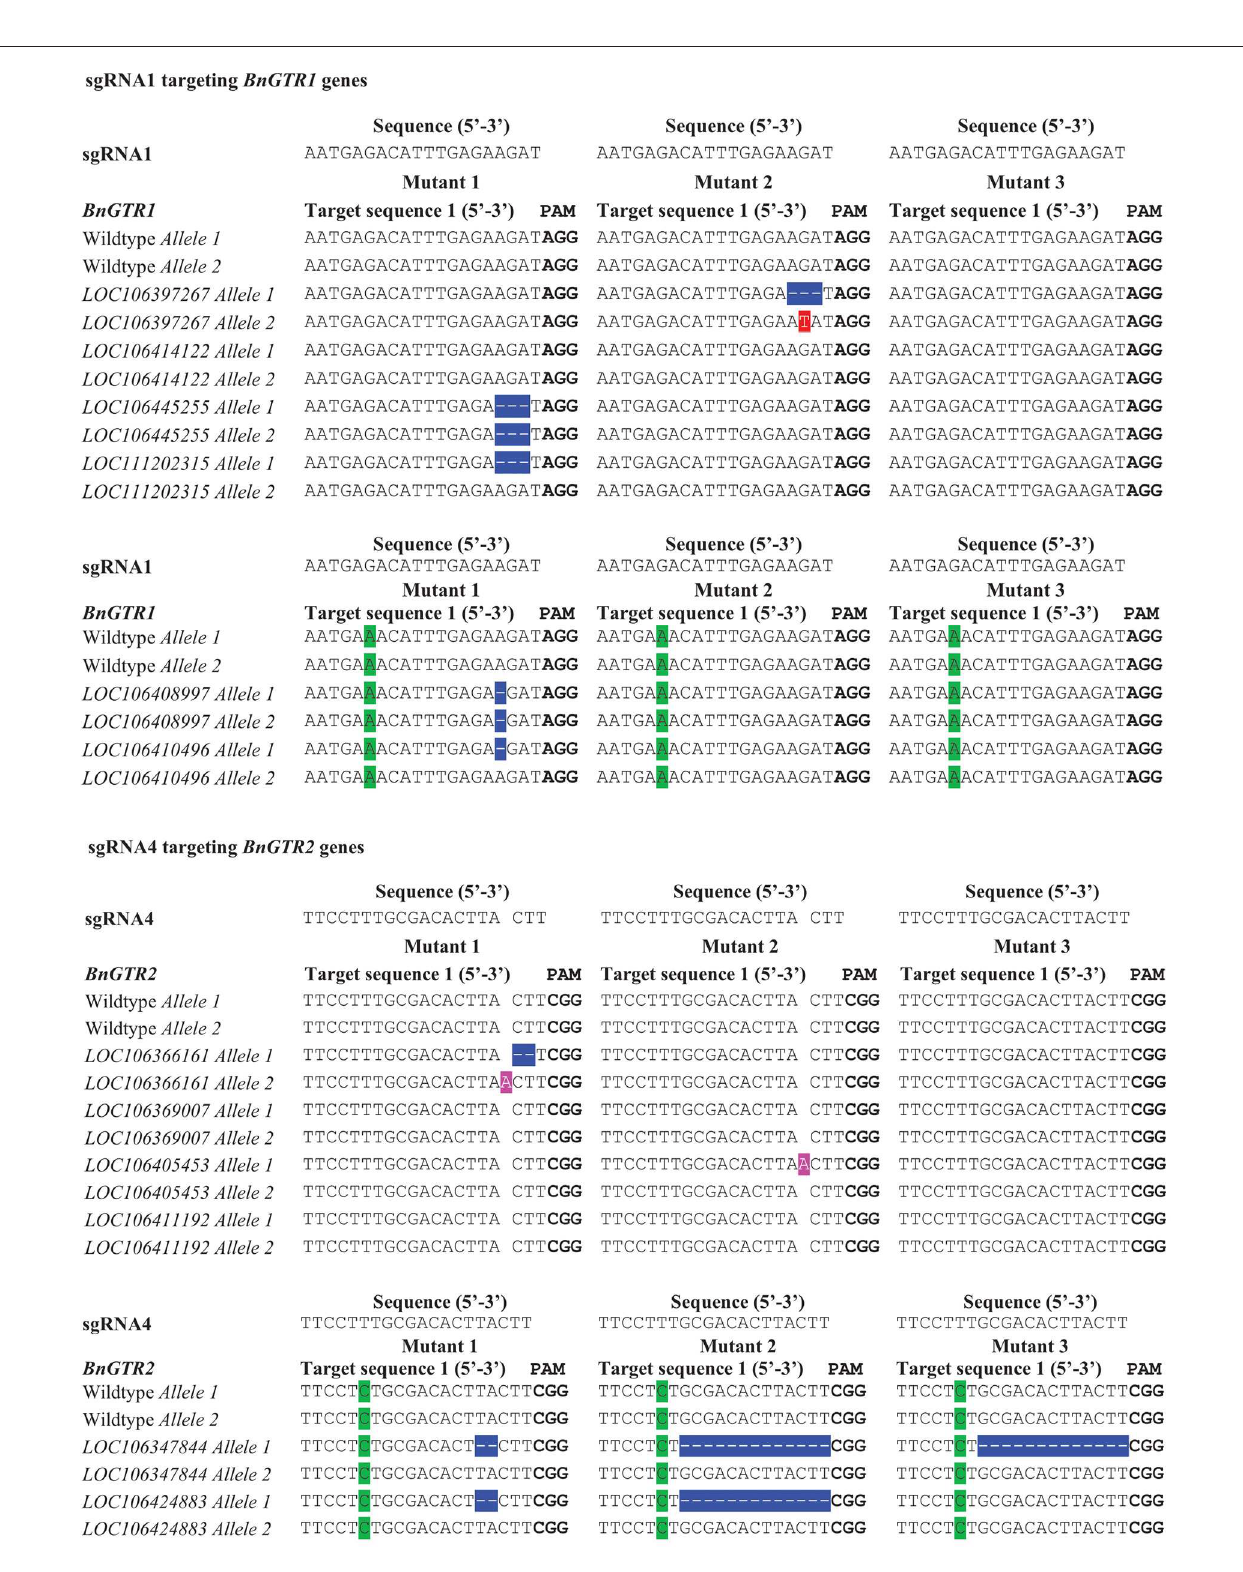
FIGURE 2 | Types of mutations in the BnGTR1 and BnGTR2 genes detected in the three mutants in comparison with wild type of rapeseed cv. Kumily, determined by DNA sequencing. PAM sites are highlighted in bold letters. Mismatches with the sgRNAs are highlighted in green. Mutated nucleotides were highlighted in different colors, in which deletions are shown with hyphens in blue, substitution and insertions are highlighted in red and pink, respectively.